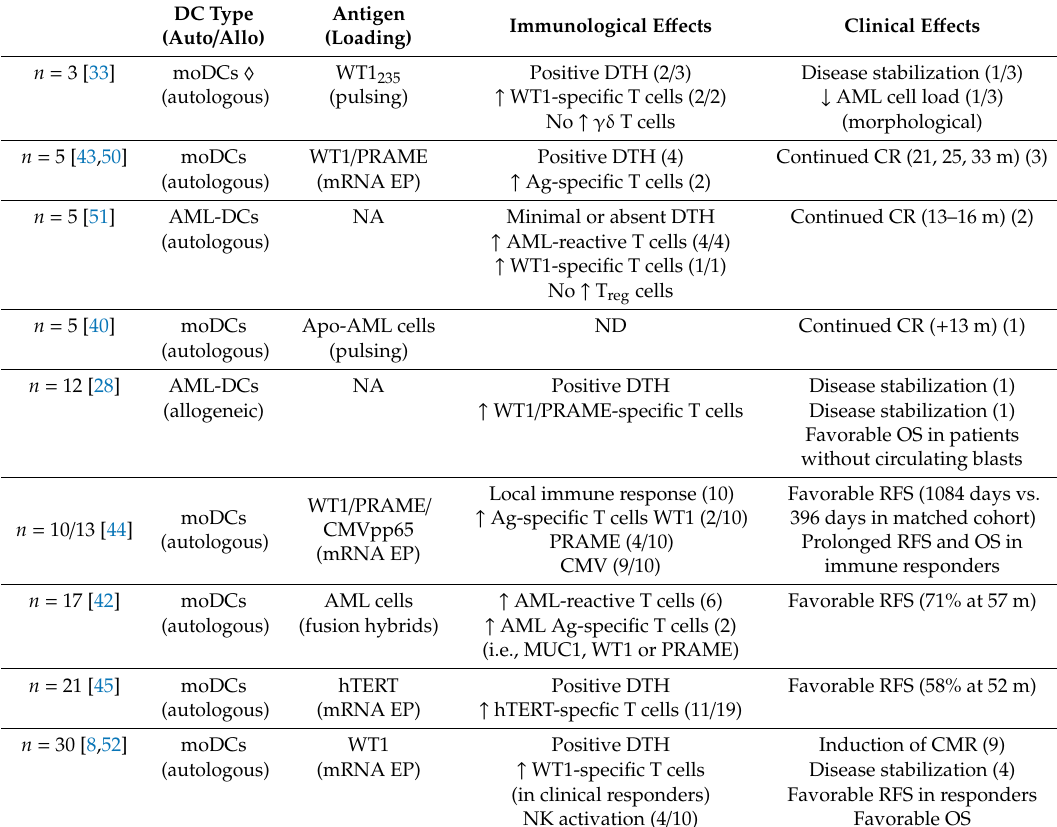
Table 3. Overview of DC vaccine studies for AML in a post-remission